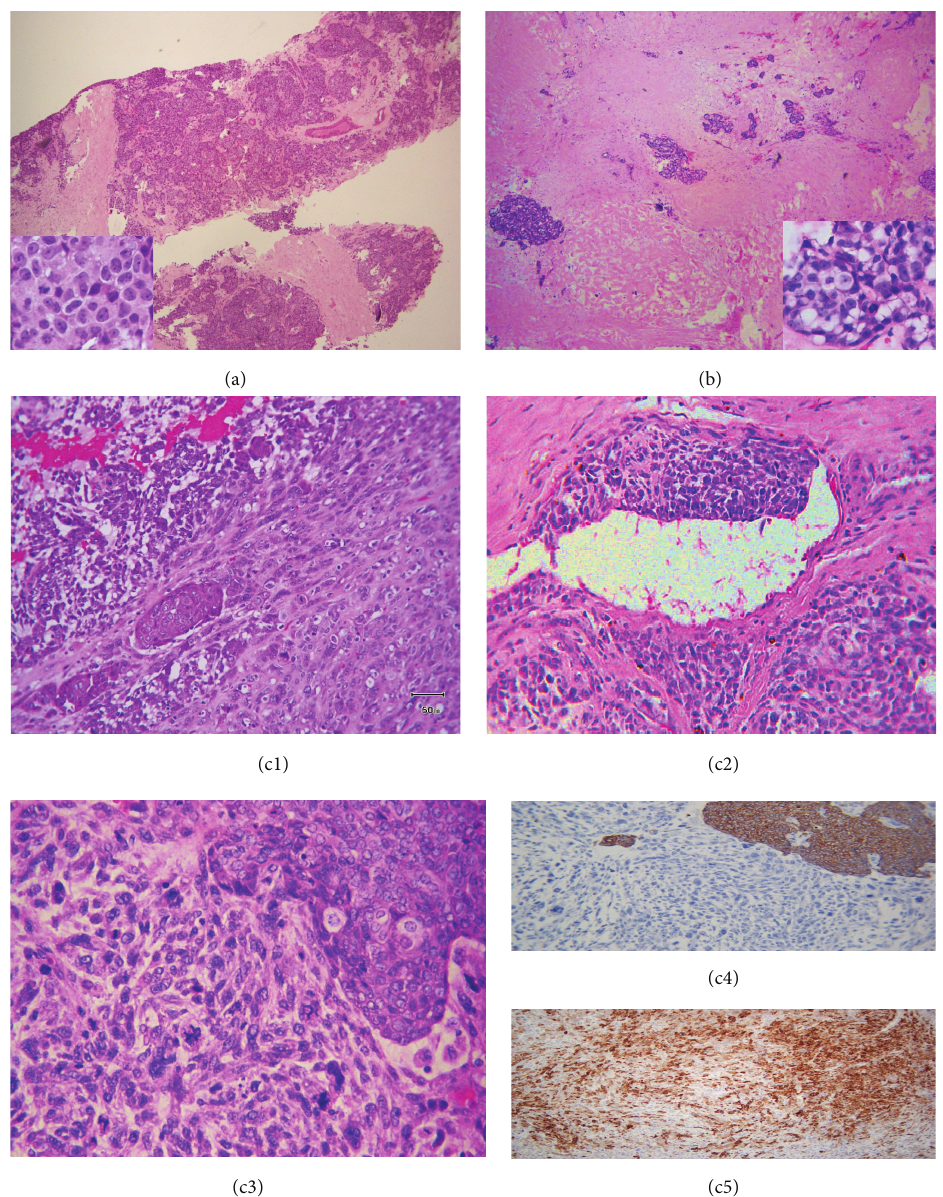
Figure1:Invasiveductalcarcinomaintheleftbreastbefore(a)andafter(b)neoadjuvanttherapyandaxillarymetaplasticbreastcarcinoma(c). (a) Cellular tumor clusters with poor tubular formation ( × 20), moderate pleomorphism and occasional mitosis ( × 100 inset). (b) Tumor islets separated by fibrosis ( × 20), composed of cells with cytoplasmic empty vacuoles and occasional pyknosis consistent with therapy effect ( × 100 inset). (c1) Intertwining spindle cells, adenocarcinoma, and squamous cell carcinoma ( × 40). (c2) Vascular invasion ( × 20). (c3–c5) Spindle and poorly differentiated squamous components with different stains. (c3) HE ( × 40); (c4) AE1/AE3 ( × 40); (c5) smooth muscle myosin heavy chain ( ×